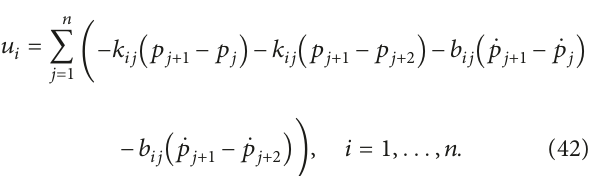
Figure 8: Initial condition displacement response for different damping ratios.